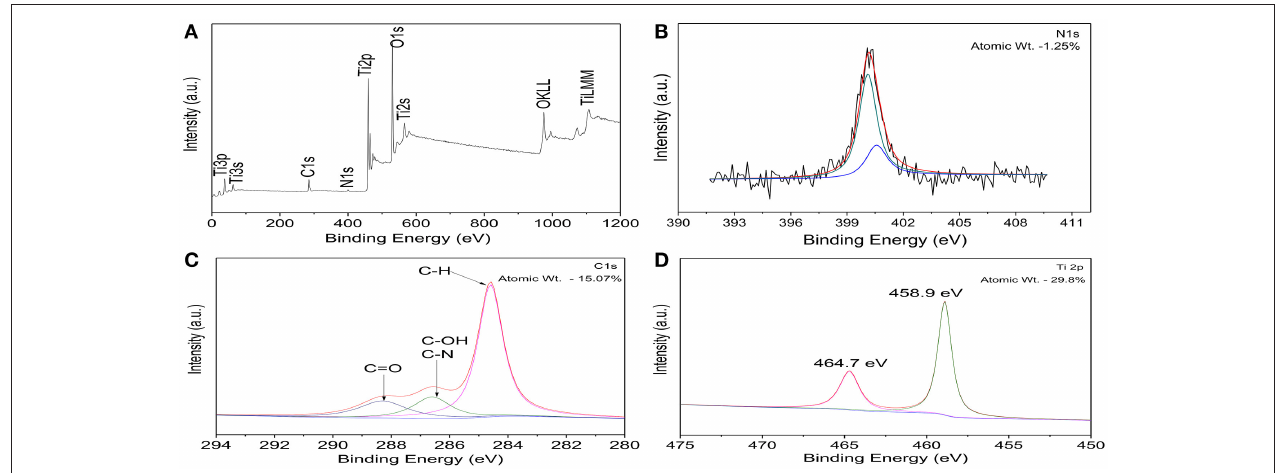
FIGURE 1 | (A) XPS survey spectrum of C, N-TiO 2 . High resolution XPS spectra of C, N-TiO 2 : (B) N1s (C) C1s (D) Ti2p.